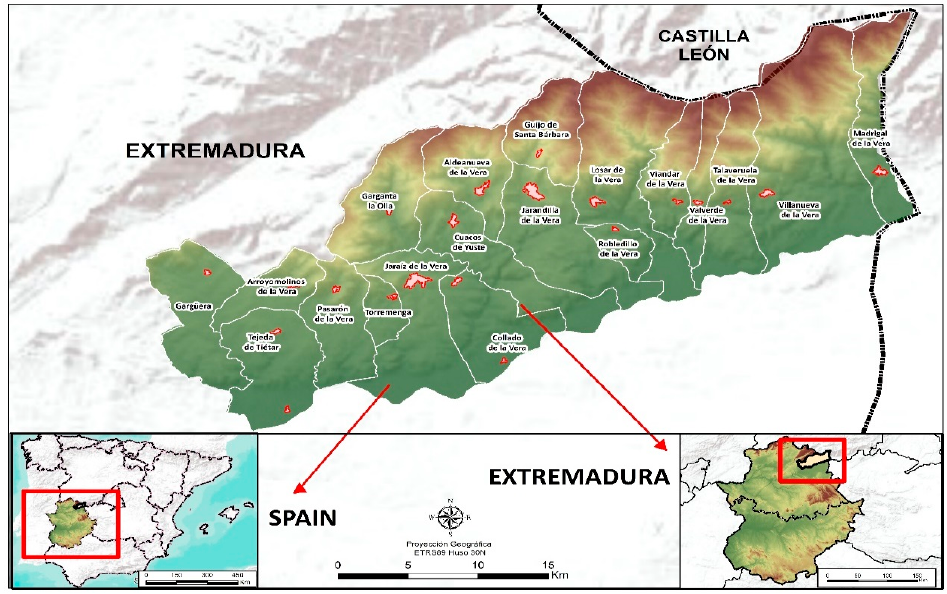
Figure 1. Boundaries and location of La Vera. Source: Own elaboration.